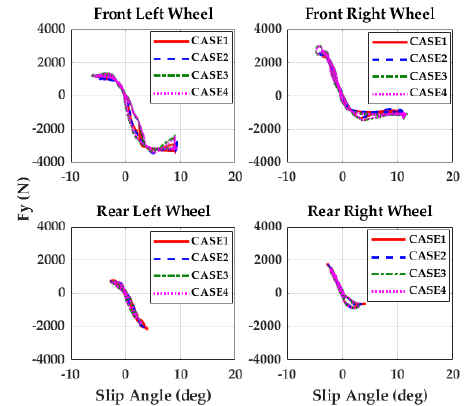
Figure 9. Lateral tire forces with respect to slip angles for each case.